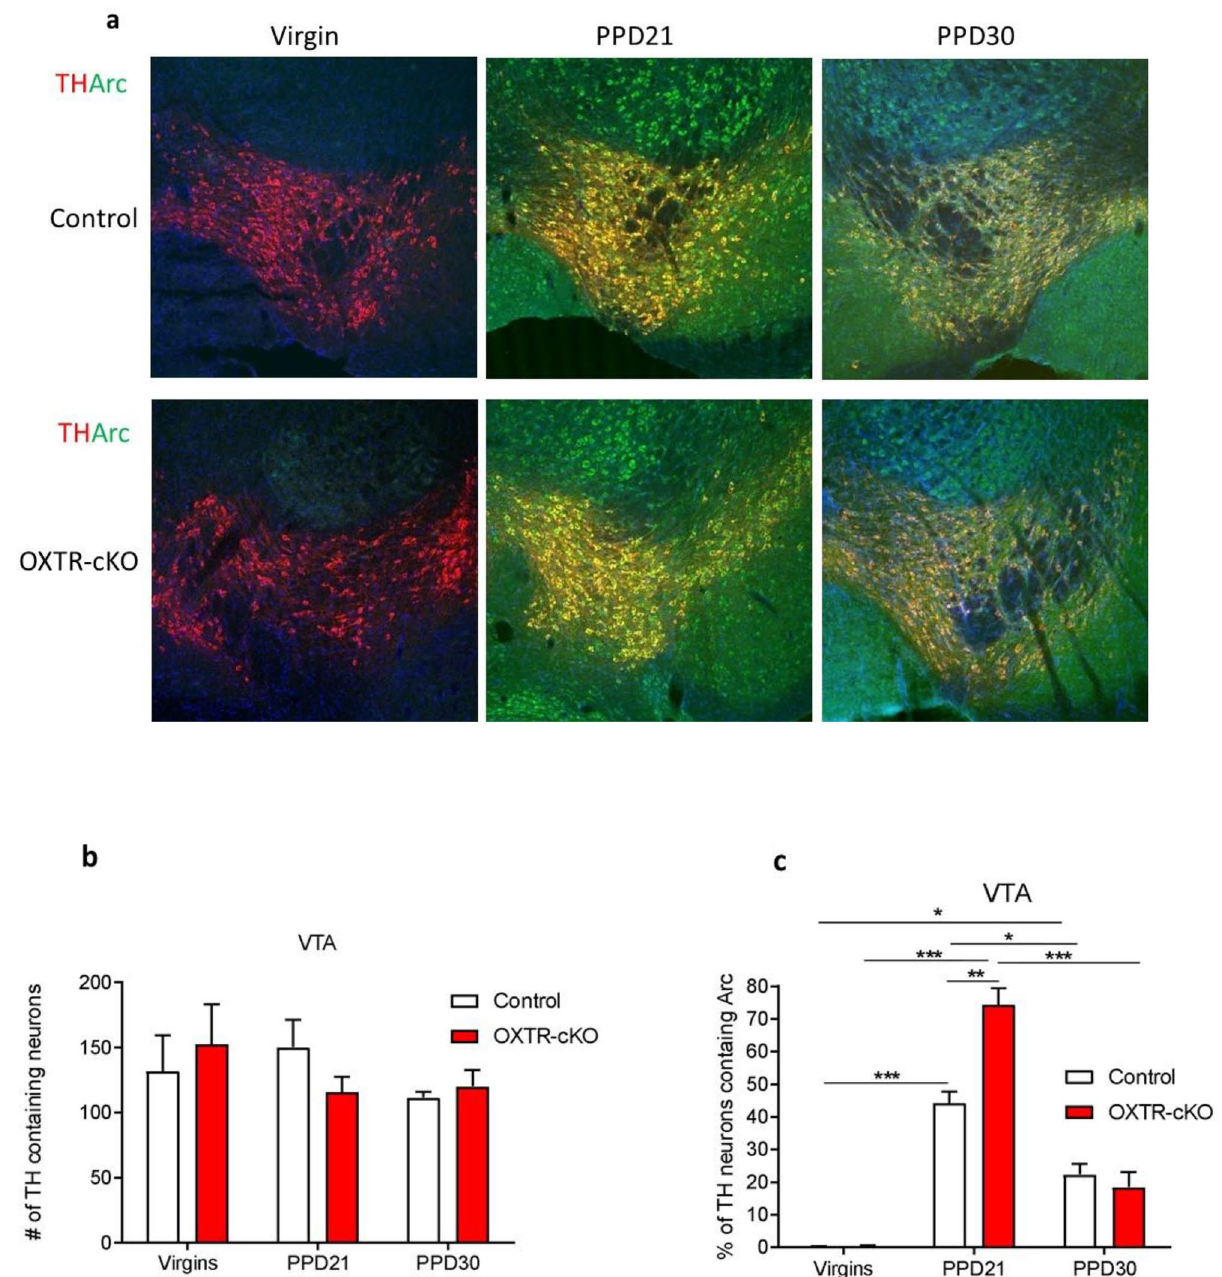
Figure 5. Maternal experience and OXTR deletion from MCH neurons cause alterations of Arc expression in the VTA dopamine neurons. ( a ) Representative image of Arc and TH immunostaining in the VTA in the different groups. Scale: 20 µm. ( b ) Number of TH positive neurons in the VTA (virgin: n control = 3, n OXTR-cKO = 3; PPD21: n control = 3, n OXTR-cKO = 5; PPD30: n control = 5, n OXTR-cKO = 5, P > 0.05, two-way ANOVA followed by Tukey’s multiple comparisons test); ( c ) percentage of TH positive neurons containing in the VTA (virgin: n control = 3, n OXTR-cKO = 3; PPD21: n control = 3, n OXTR-cKO = 5; PPD30: n control = 5, n OXTR-cKO = 5, * P < 0.05, ** P < 0.01, *** P < 0.001, two-way ANOVA followed by Tukey’s multiple comparisons Mating behavior affects mood responses to OXTR deletion from MCH neurons in a sex‑depend ‑ ent manner. To examine the effects of mating on emotional behavior, control and OXTR-cKO male and female mice were allowed to mate (within the same genotype group) for 3 days, and were tested 24 h after the last contact in the forced swim test. Mating activity did not change the immobility time in the control female mice ( P > 0.05 mated control mice compared to naïve control mice), suggesting that sexual activity does not affect the basal levels of mood in female mice (Fig. 7a). However, mating restored the elevated immobility time observed in OXTR-cKO mice to levels comparable to those seen in control mice ( P > 0.05: mated OXTR-cKO female mice